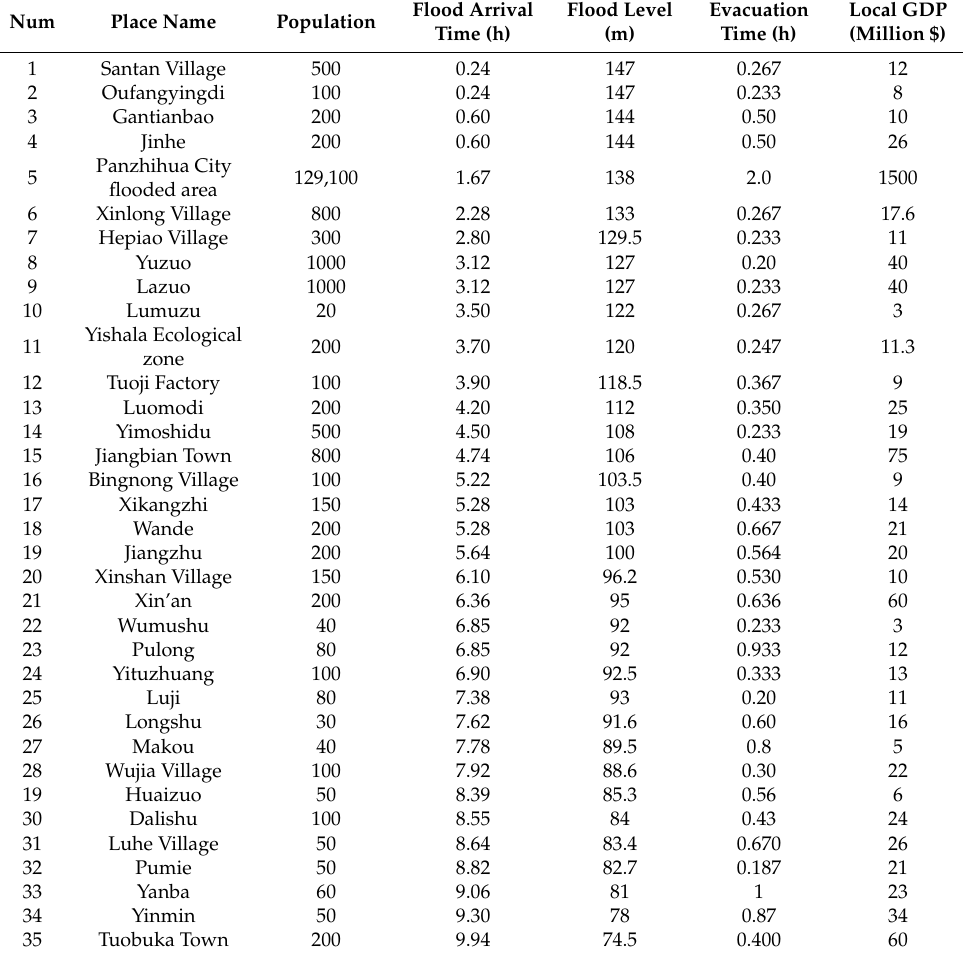
Table 4. Residential areas